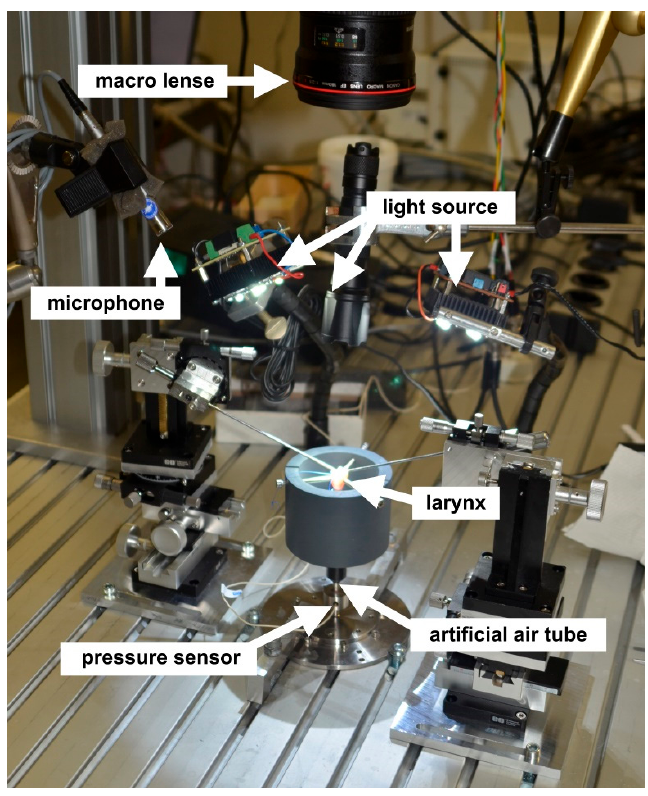
Figure 2. Overview of the experimental setup with inscriptions.